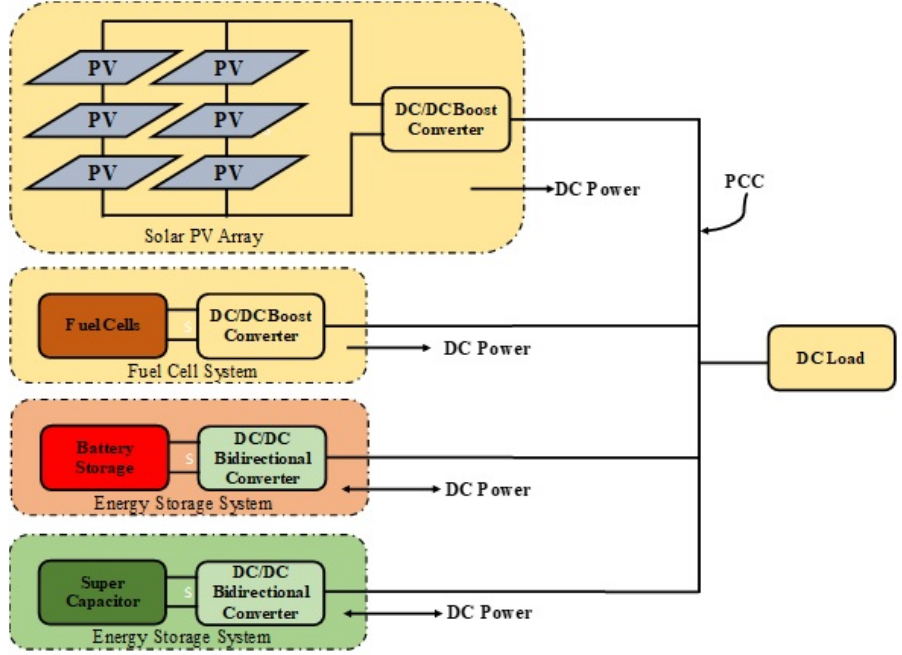
Figure 1. Block diagram of hybrid DC MG.